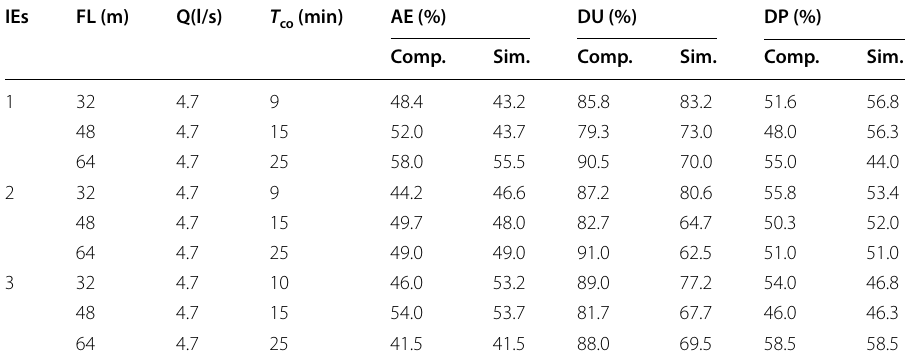
Table 4 Computed and simulated performance indicators for existing furrow irrigation